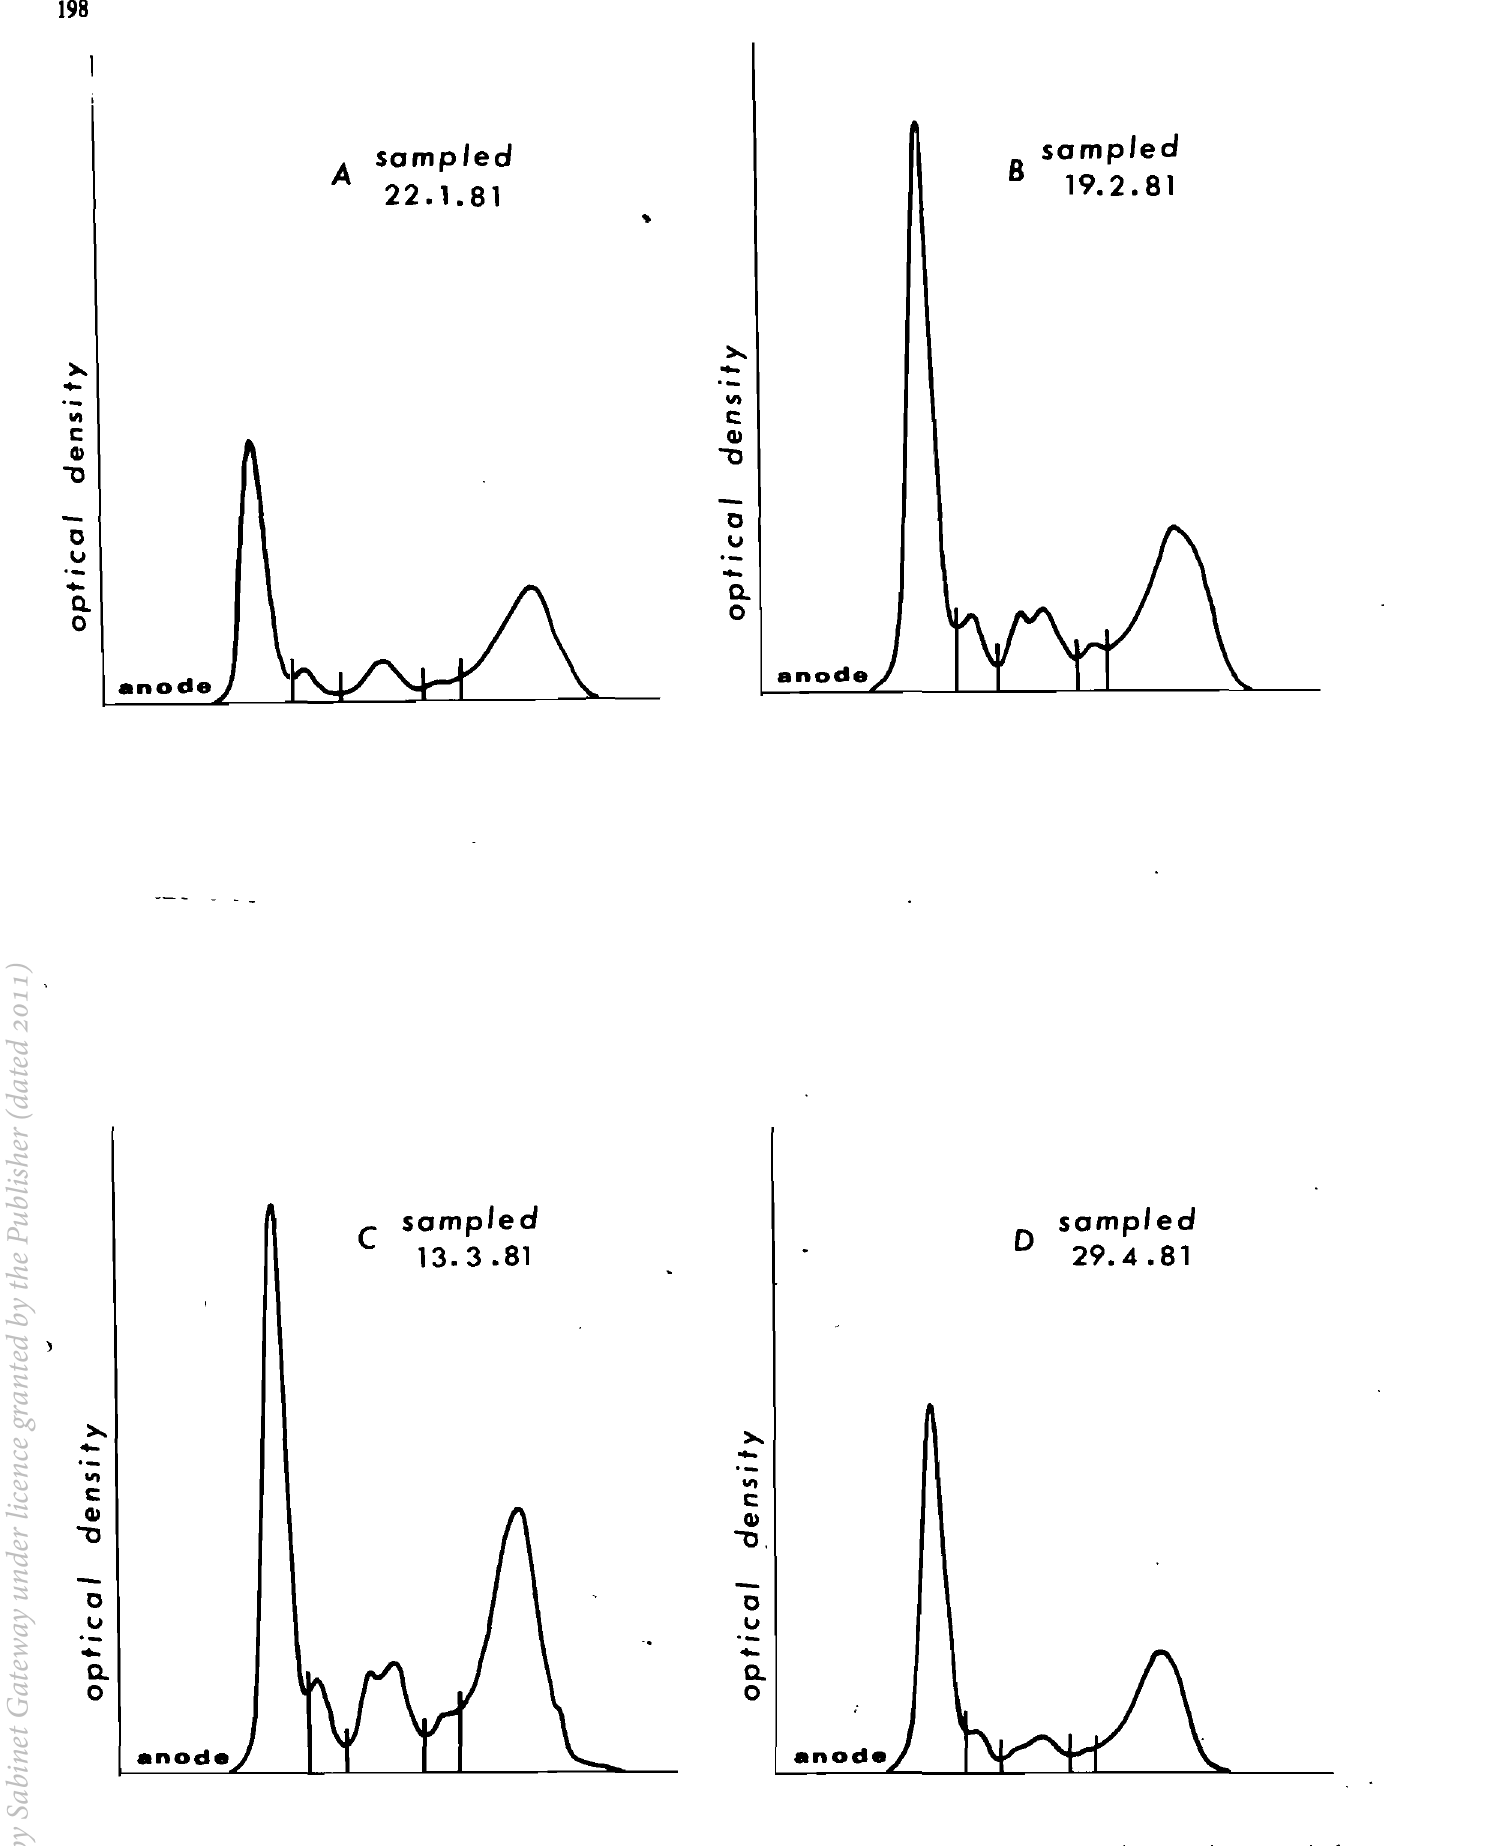
Fig. 6 A - D: Cellulose acetate electrophoretograms recorded for four blood sampling periods and obtained using a barbitone buf fer, pH B,6, with a milliamperage of 2 mAo TYDSKRIF VAN DIE SUID-AFRIKAANSE VETERIN£RE VERENIGING-SEPTEMBER